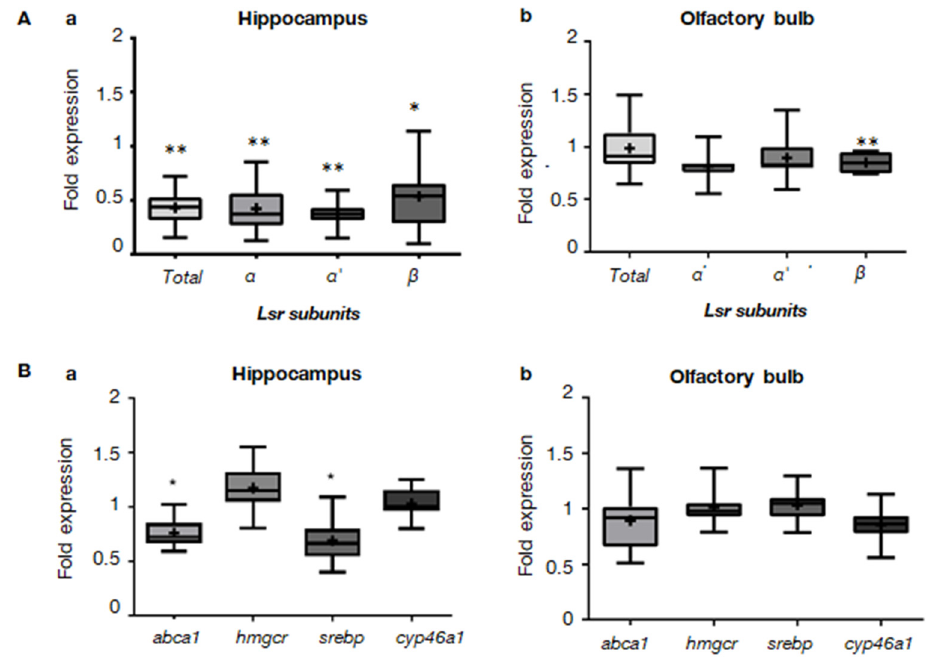
Figure 1. Modification of gene expression in astroglial Lsr cKO mice. ( A ) Verification of Lsr gene excision in astroglial cells using RT-qPCR. Box plot presentation of fold expression of total Lsr and different Lsr subunits α , α ’, and β in 13-month-old cKO mice ( n = 5) with respect to WT mice ( n = 5) in the hippocampus ( a ) and olfactory bulb ( b ). ( B ) Box plot presentation of fold expression of cholesterol-related gene expression in 13-month-old cKO mice ( n = 5) with respect to WT mice ( n = 5) in the hippocampus ( a ) and olfactory bulb ( b ). Abbreviations: abca1 , ATP-binding cassette transporter 1; hmgcr , HMG CoA reductase; srebp1 , sterol regulatory element-binding transcription factor 1; cyp46a1 , cytochrome P450 family 46 subfamily A member 1. Statistical significance between WT and cKO mice is shown as: * p ≤ 0.05, ** p ≤